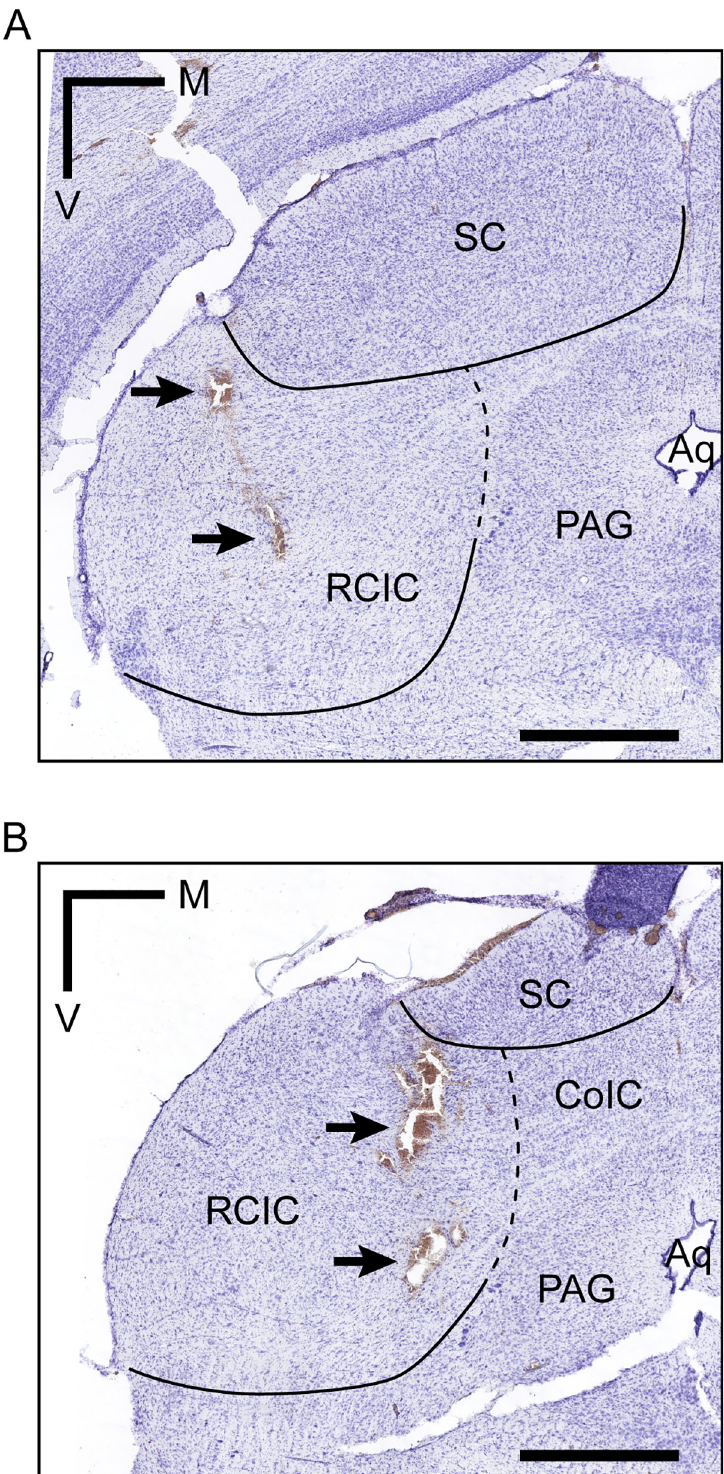
Fig 1. Histological location. ( A, B) Coronal sections from 2 different animals showing electrolytic lesions (arrows) in the RCIC. Scale bar = 1 mm. Aq, aqueduct; CoIC, commissure of the inferior colliculus; M, medial; PAG, periaqueductal gray; RCIC, rostral cortex of the inferior colliculus; SC, superior colliculus; V, ventral.